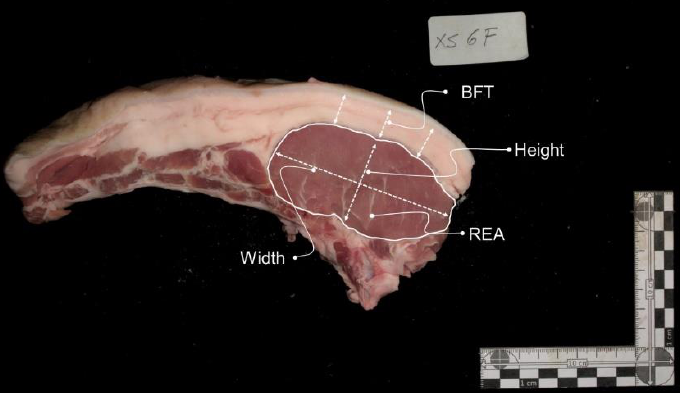
Figure 1. Image illustrating the muscle and subcutaneous fat measurements. LTL—Longissimus thoracis et lumborum; width—maximum width of LTL muscle; height—maximum height of LTL muscle; REA—rib eye area; BFT—backfat thickness.